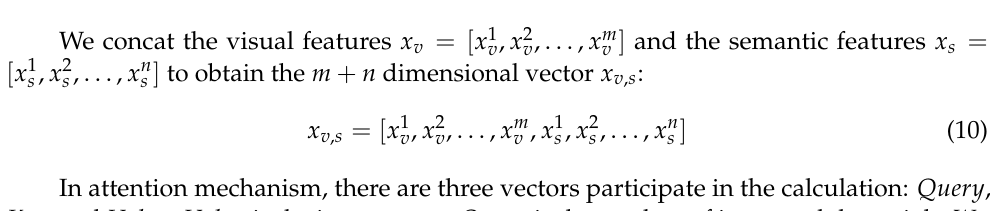
Figure 7. The self-attention based multimodal